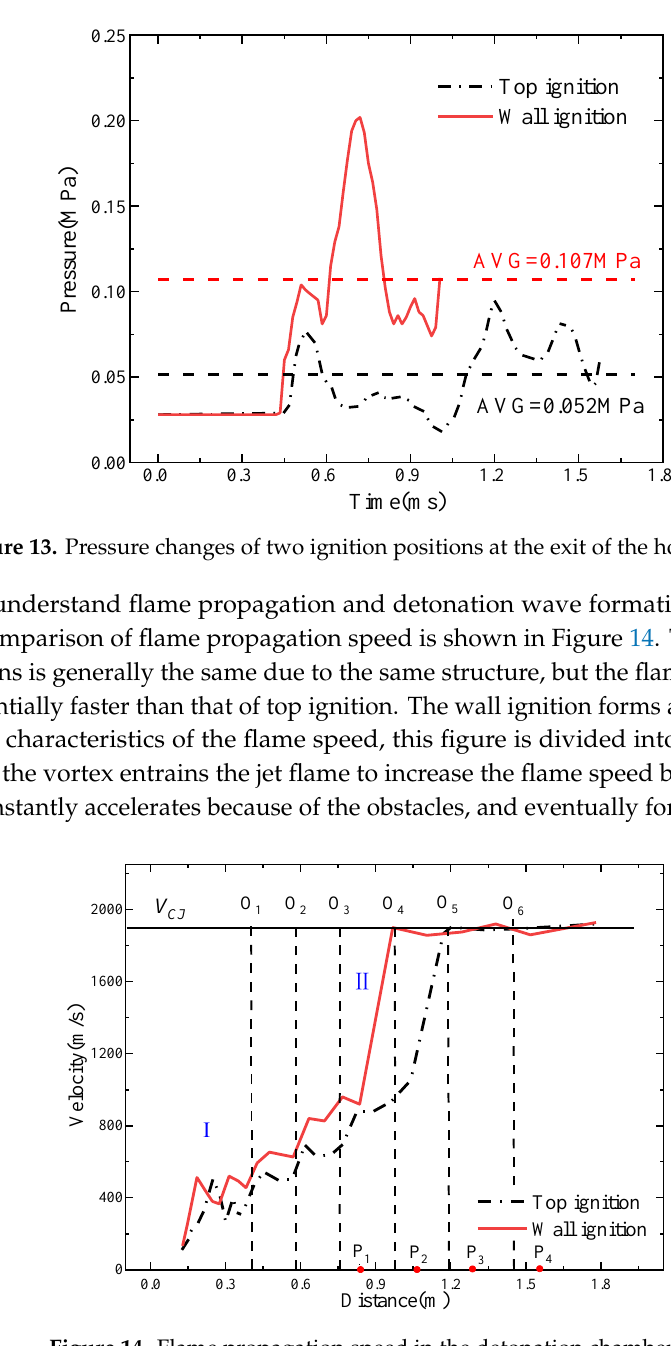
Figure 12. Variations of temperature field of the wall ignition ( a ) t HJ =0.3ms, ( b ) t HJ =0.6ms, ( c ) t HJ =0.9ms, ( d ) t HJ =1.005ms.